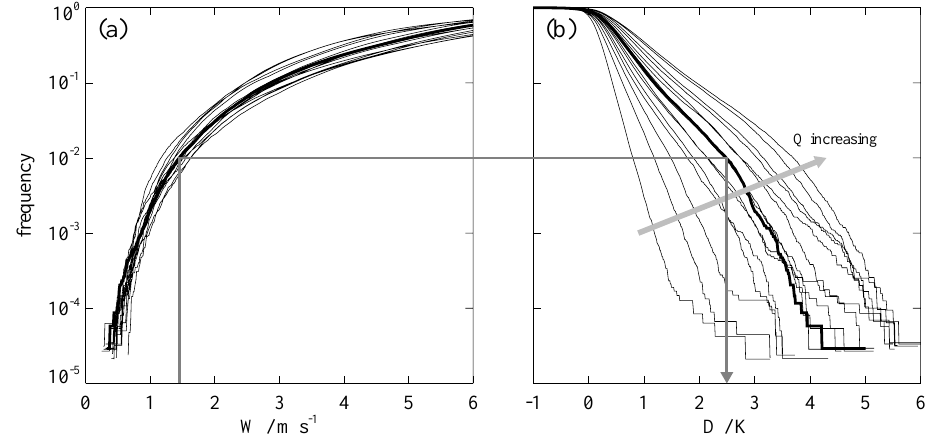
Fig. 1. Example of direct frequency matching, for 14:00LT. (a) Frequency of (maximum in 6-hourly wind speed) < W , as a function of W, (b) frequency of warming > D , as a function of D . Each curve corresponds to a different integrated heat flux ( Q) bin; Q ranges from 4.2 to 17MJm − 2 . For a given frequency, curves for larger Q tend to give larger D . Note that there is covariance of W and Q (from varying atmospheric stability and varying sensible and latent heat fluxes) and this is included in the resulting model. The concept of frequency matching is that (following the thin grey arrow), for a particular Q bin (bold curves), persistent wind speeds less than 1.4ms − 1 occur with frequency 10 − 2 in the NWP data, which corresponds to the frequency of warming greater than